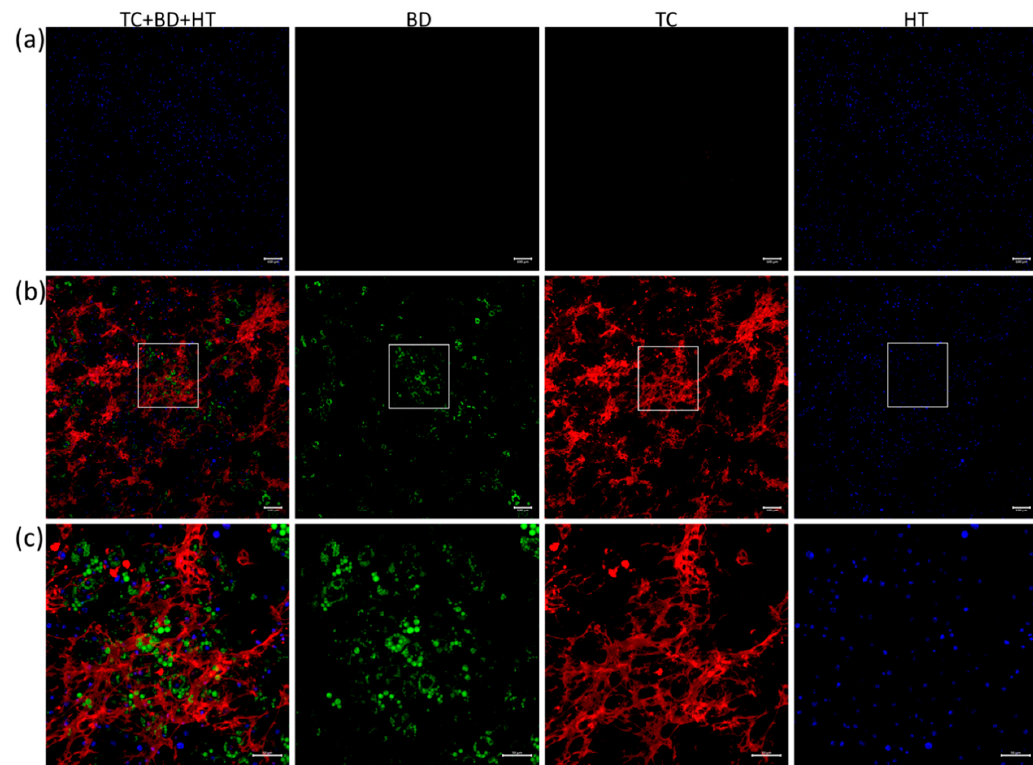
Figure 2. Confocal imaging of MSC cultures after combined TC, BD and HT labelling at day 21. Culture under undifferentiated ( a ) and differentiated ( b , c ) conditions observed using confocal microscopy showed specific signalfrom BD (green) and TC (red) in differentiated cultures, which could be combined with HT (blue) nuclear staining. Scale bar = 100 μ m. ( c ) High-magnification view of the differentiated cells. Scale bar = 50 μ m.